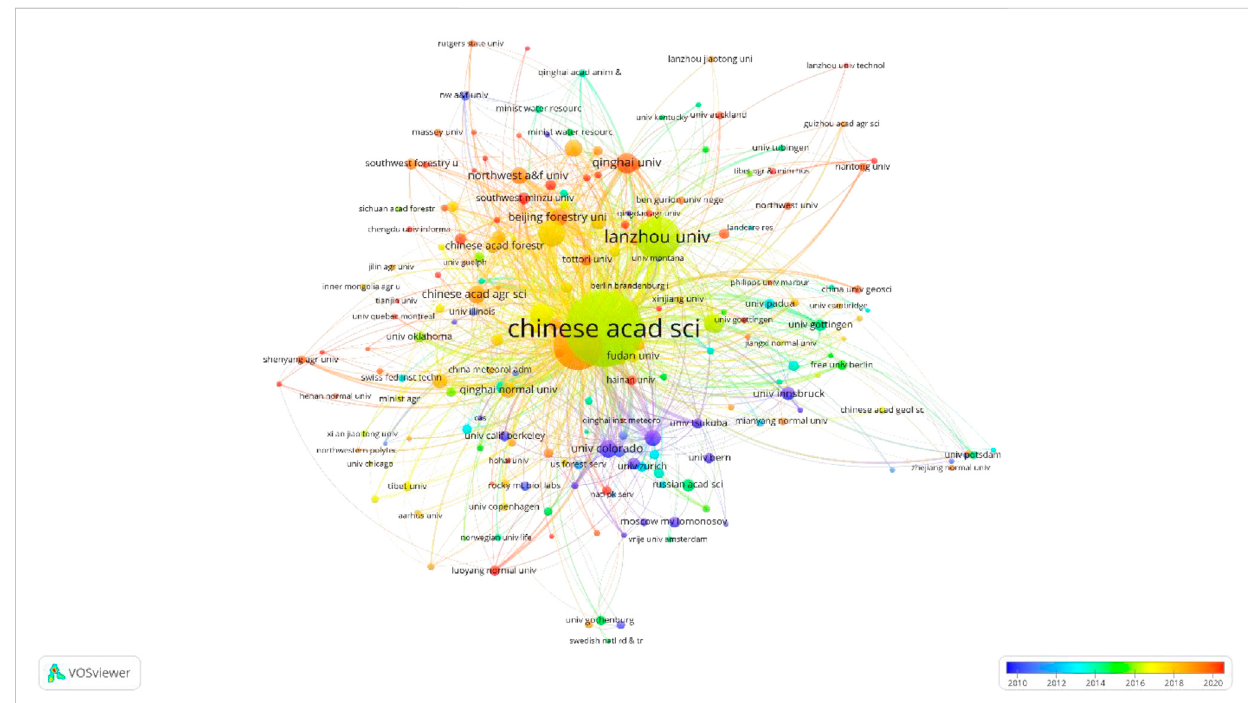
FIGURE 7 Clustering analysis of the temporal overlay mapping of papers published by institutions in the fi eld of alpine meadow